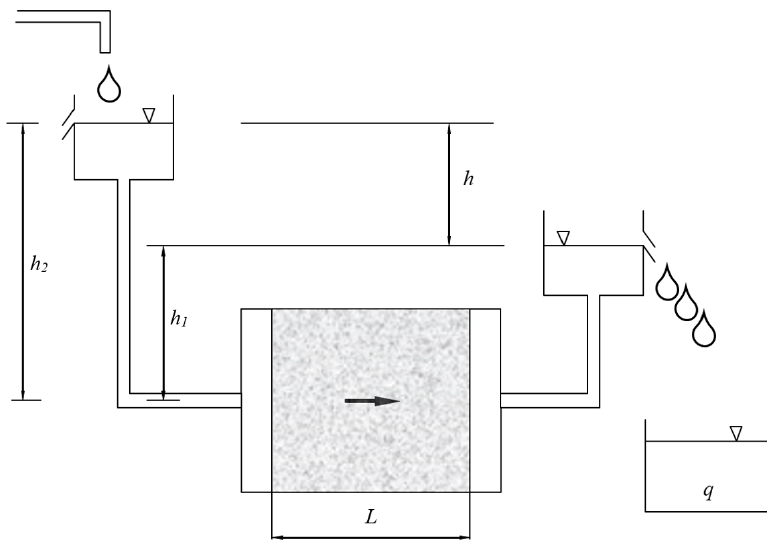
Figure 3. Scheme of constant head permeability test.